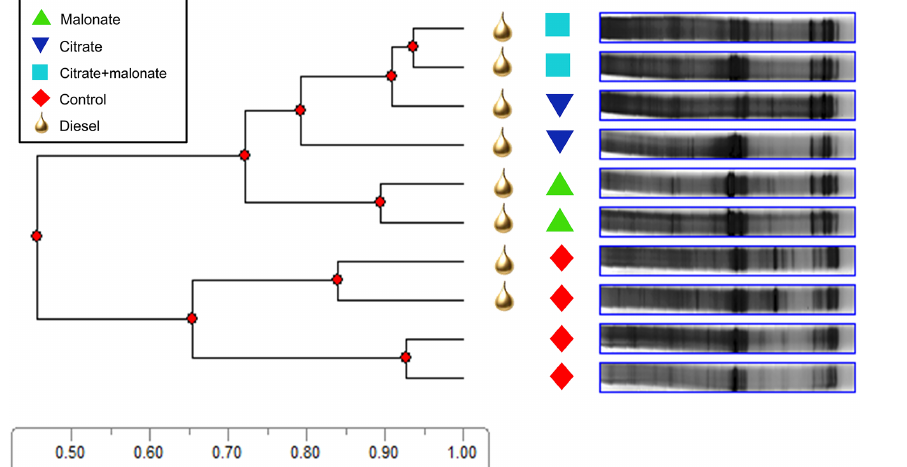
Figure 4. UPGMA dendrogram of 16s rRNA DGGE bacterial community profiles after 18 days of incubation in diesel-contaminated and un- contaminated soil which received water (control) and diesel-contaminated soil that received 5µmolg − 1 soil of malonate, citrate + malonate, or citrate every 48h. The scale represents the similarity coefficient.